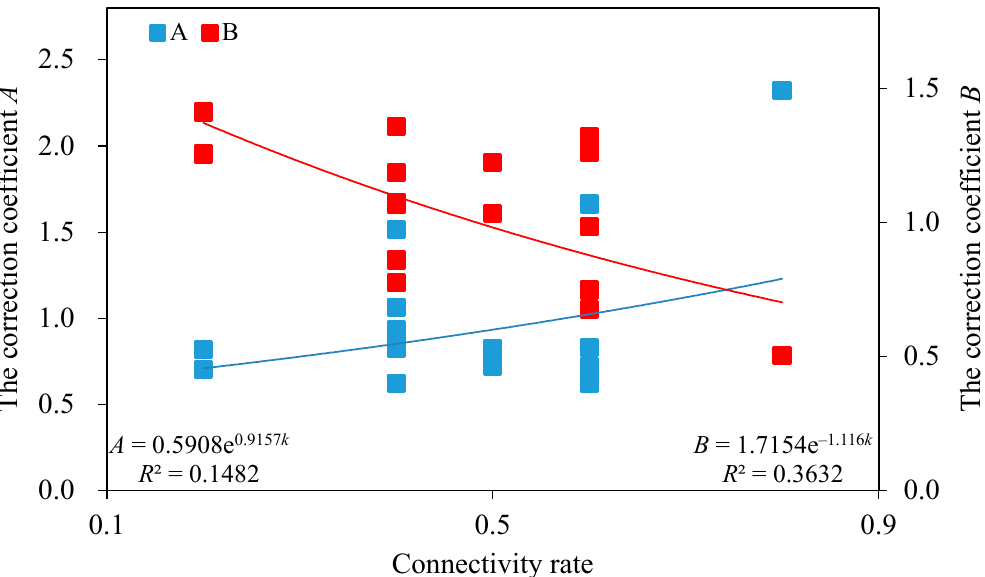
Figure 2. The correction coefficient A of the cohesion and the correction coefficient B of the internal friction coefficient for rock bridges with the connectivity rate.